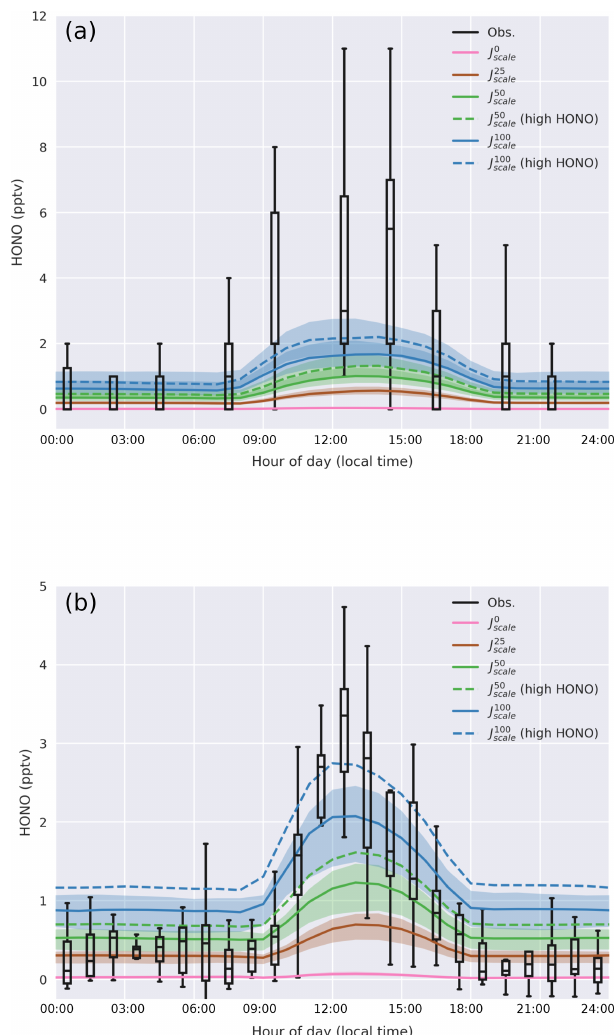
Figure 6. Observed and modeled diurnal cycles of HONO at CVAO. Panel (a) shows the comparison of model results for May from the 2014–2015 simulations with measurements during the spring 2007 RHaMBLe campaign (Sander et al., 2013). Panel (b) shows com- parison of model results with measurements (Reed et al., 2017) during November–December 2015. Measurements are shown in box-and-whisker notation, with the box showing the lower and up- per quartile values (with a horizontal line at the median) and the whiskers extending to 1.5 times the interquartile range of the data. Solid and dashed lines represent model median values for simula- tions with a HONO : NO 2 molar yield of 0 . 67 : 0 . 33 and 0 . 93 : 0 . 07 (denoted as “high HONO”), respectively, from NITs photolysis. Shaded regions show first and third quartiles of model